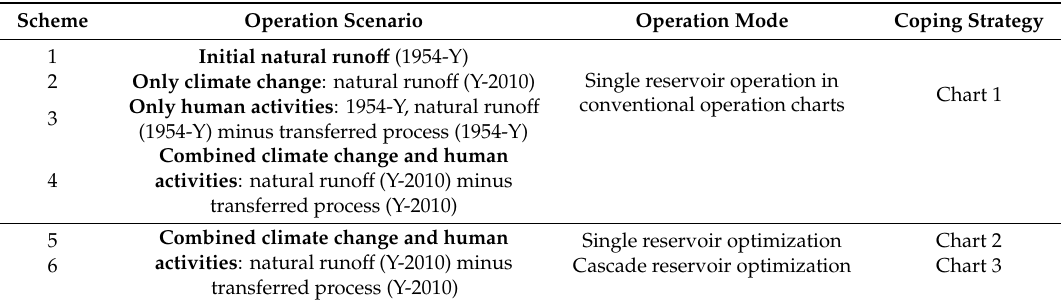
Table 3. Calculation schemes and the operation